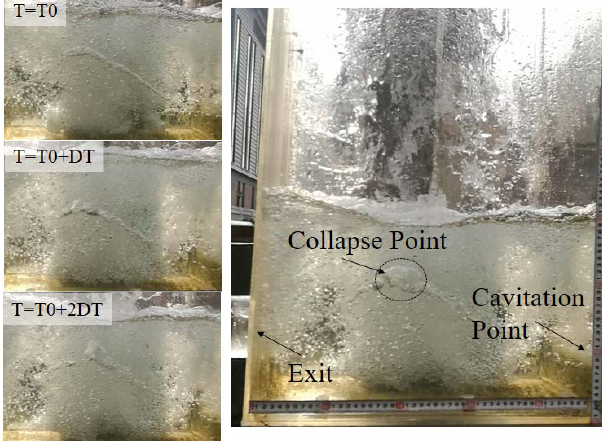
Figure 5. Front view of a forming process of the submerged horizontal vortex.